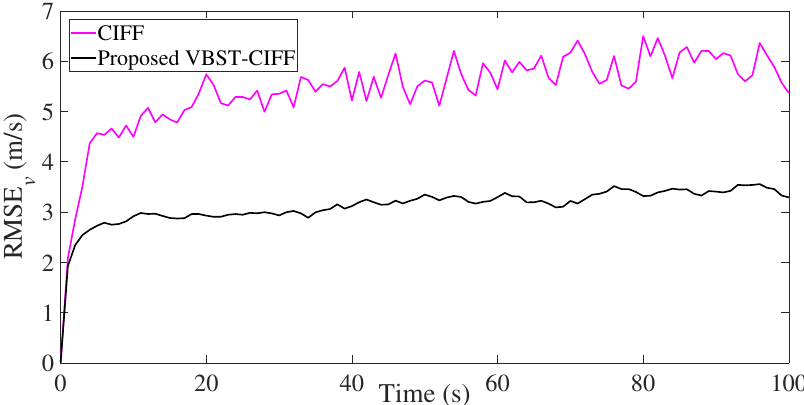
Figure 10. Velocity RMSE of fusion in multi-sensor target tracking.